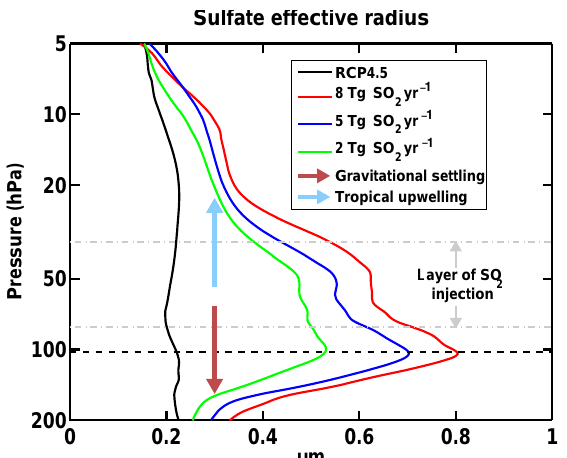
Figure 1. Annual averaged vertical profiles of aerosol effective ra- dius (µm) in the tropical stratosphere (25 ◦ S–25 ◦ N), with increas- ing geoengineering injection of SO 2 (see legend). The heavy dashed line indicates the mean tropical tropopause. Profiles are calculated in the University of L’Aquila Chemistry–Climate Model (ULAQ- CCM), which includes explicit gas–particle conversion and aerosol microphysics (Pitari et al.,